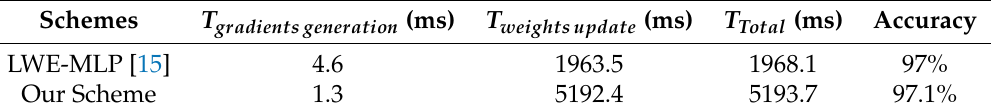
Figure 5. Experimental results comparison. Table 5. Experimental results comparison.